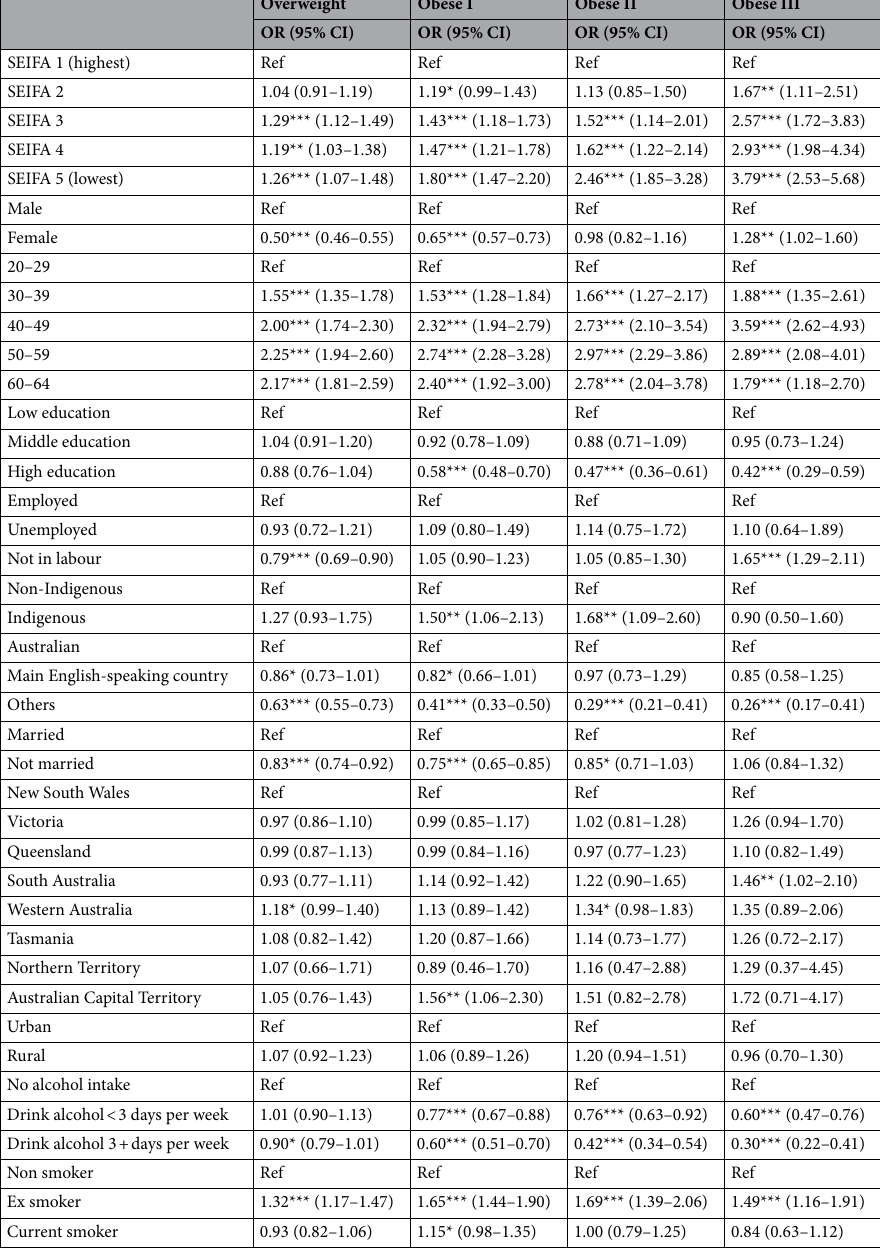
Table 2. Determinants of obesity levels. Regressions were adjusted for sex, age group, education level, household income, indigenous status, country of birth, marital status, Australian state, residential area, alcohol intake, and smoking. *** p < 0.01. ** p < 0.05. * p <